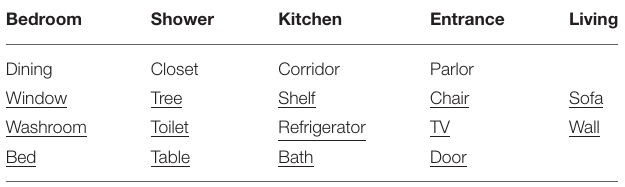
Bath Door Underlined words are not included in the Places205